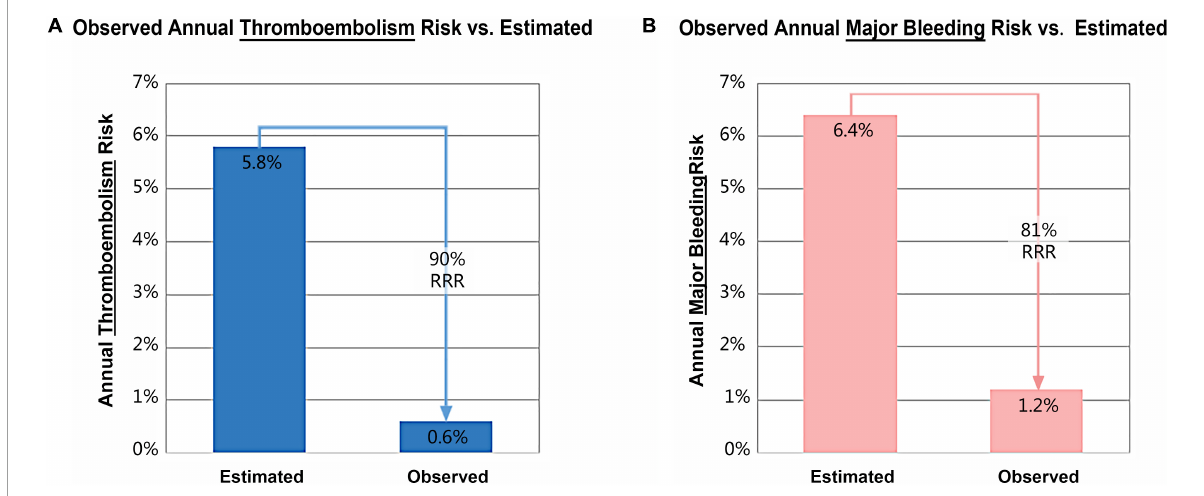
FIGURE3 Relative risk reduction (RRR) in annual thromboembolism (A) and major bleeding (B) after left atrial appendage closure with LACbes R (cid:13)